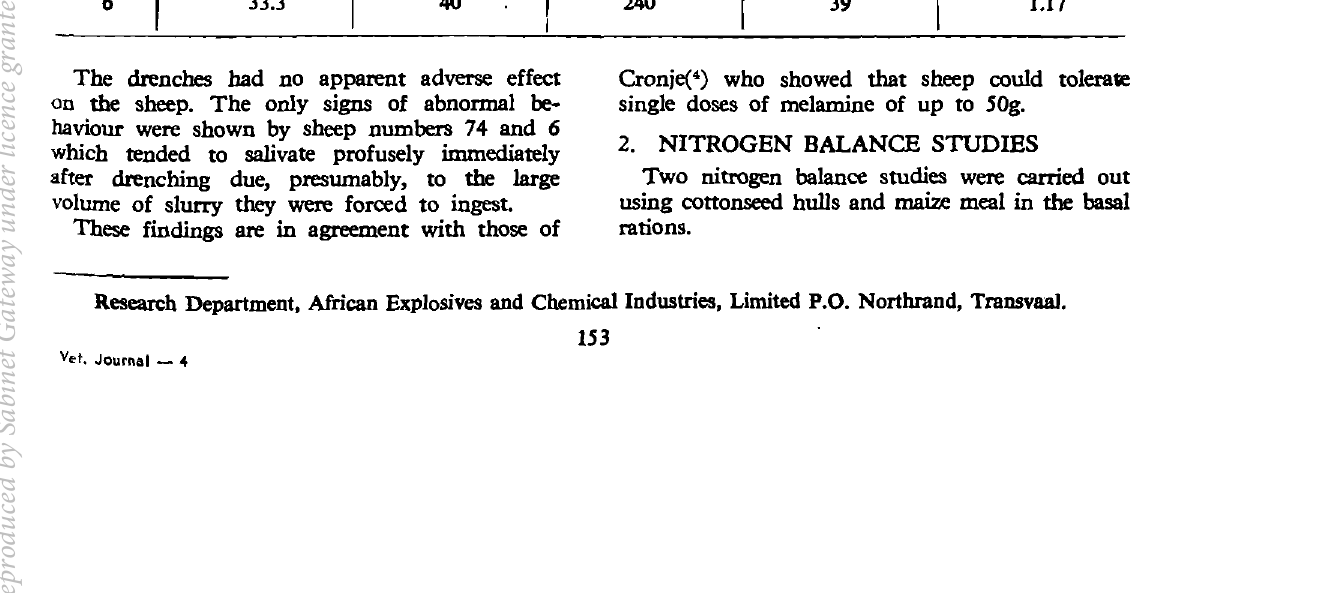
TABLE I.-LIvEWIl10HT OF EWES AND DOSAOE RATES OF MELAMINI! IN WATER. Dosages Sheep Liveweight